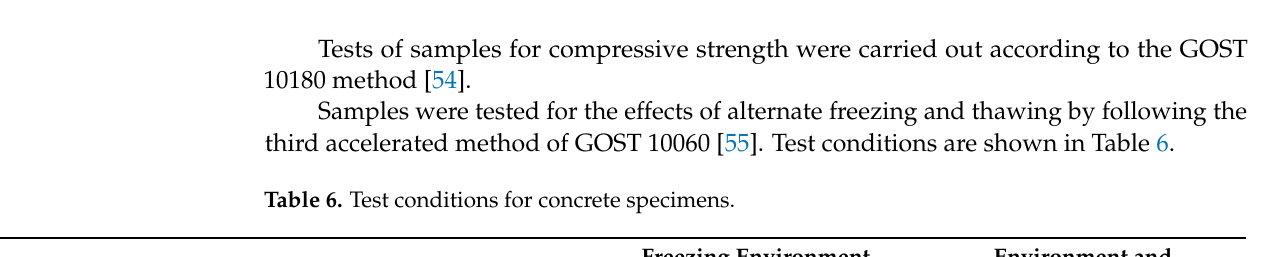
Table 6. Test conditions for concrete specimens.